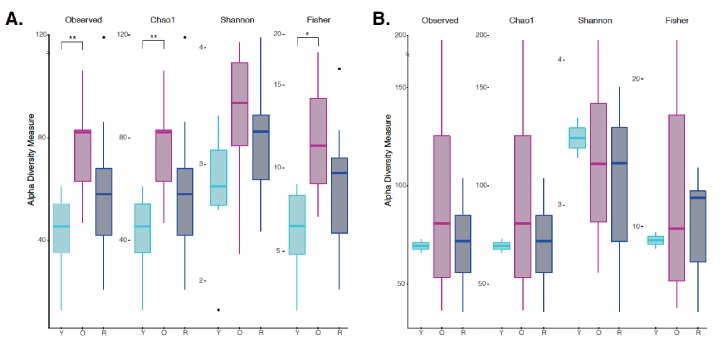
Independent Alpha Diversity Analysis for JAX and UW-NIA animals.(A) Alpha Diversity measures for JAX Lab animals, including 6 month old (Y), 22 month old (O), and 22-month-old mice treated with rapamycin (R). (B) Alpha Diversity Measures for UW-NIA animals, including Y, O, and R mice. Significant differences between the different alpha diversity measures between Y and O mice, including Observed, Chao1, and Fisher, was observed among the JAX samples. No significant difference between taxonomic richness among Y and R mice was observed in Jax samples. This result was also observed independently in the UW-NIA animals. *p<0.05, **p<0.01.